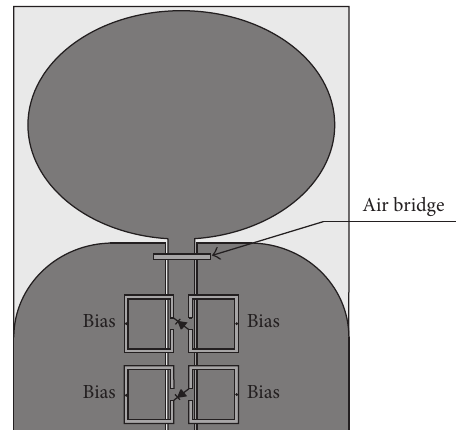
Figure 59: Geometry of the reconfigurable and tunable S-shaped split-ring resonators (S-SRRs) antenna for UWB applications [68]. An air bridge is adopted to suppress the slot line mode, which can be excited by the asymmetric structures forming the filter. Dark gray upper metal face, medium gray bottom split-ring resonator and air bridge, and light gray dielectric